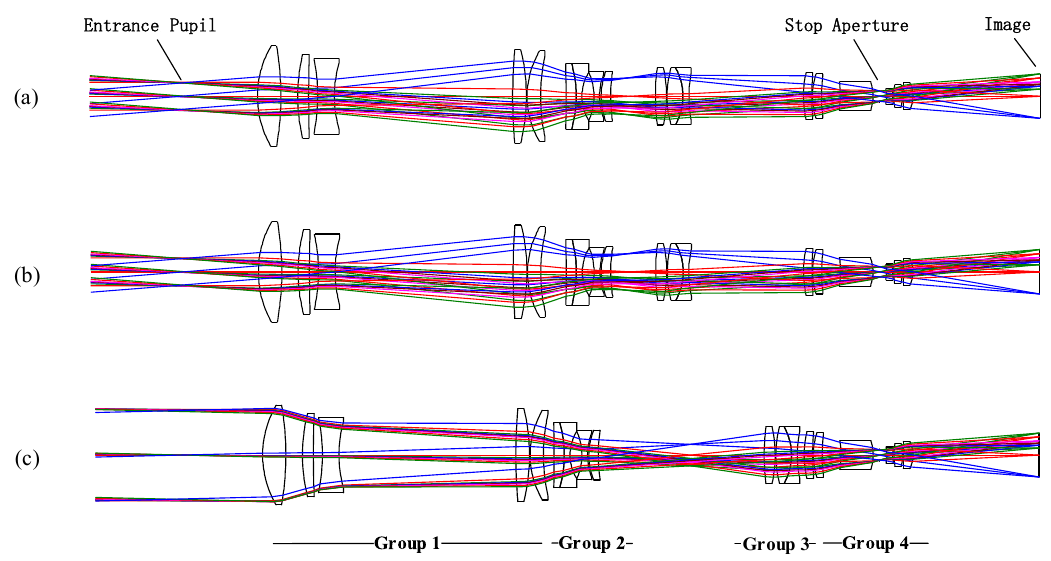
Figure 4. Design result of the 4× zoom lens with a stable entrance pupil and internal stop at focal length: ( a ) 100 mm; ( b ) 250 mm; and ( c ) 400 mm. Table 3. Lens data results for the 4× zoom lens system.